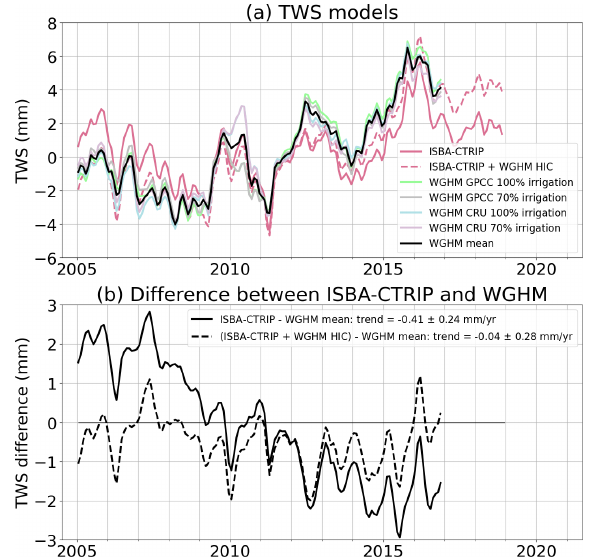
Figure 3. Comparison of ISBA-CTRIP and WGHM estimates of terrestrial water storage (TWS) variations. (a) ISBA-CTRIP and WGHM time series. The black curve corresponds to the mean of the four WGHM estimates. The red dotted curve corresponds to the sum of the ISBA-CTRIP climate contribution of the WGHM trend of human-induced contribution (HIC). (b) Difference between ISBA- CTRIP TWS and WGHM mean estimate of TWS. Linear trends of all time series over different periods of time are provided in Ta- ble S1.